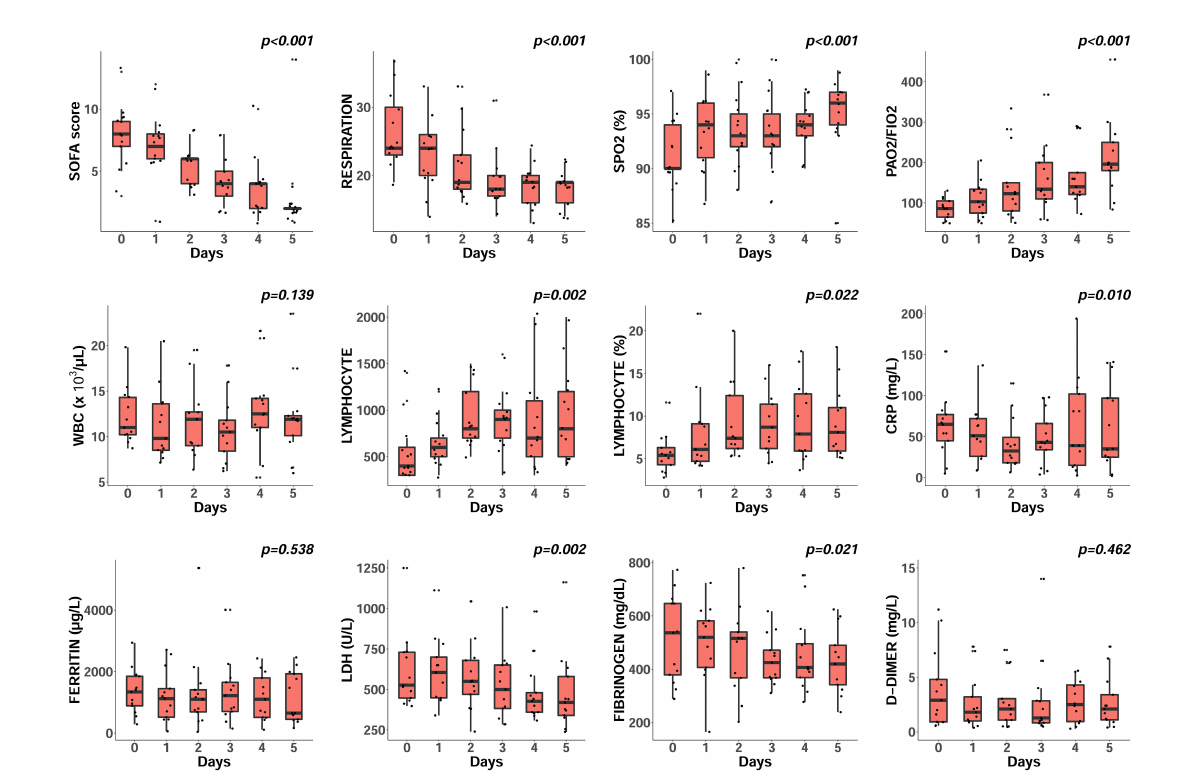
FIGURE 1 Impact of ChipEXO TM on clinical and laboratory parameters. Subjects received twice daily aerosolized ChipEXO TM treatment for 5 days. Results are shown as scattered boxplots to demonstrate the distribution of change for each parameter over time. P values, by Friedman test, indicate a within-subject comparison on six time points. There was a signi fi cant improvement in the respiratory rate, SOFA score and lymphocyte count. The SpO 2 level and PaO 2 /FiO 2 ratio dramatically increased, and CRP, LDH and fi brinogen signi fi cantly decreased during treatment. Abbreviations (normal range): WBC, white blood cell count; CRP, C-reactive protein; LDH, lactate